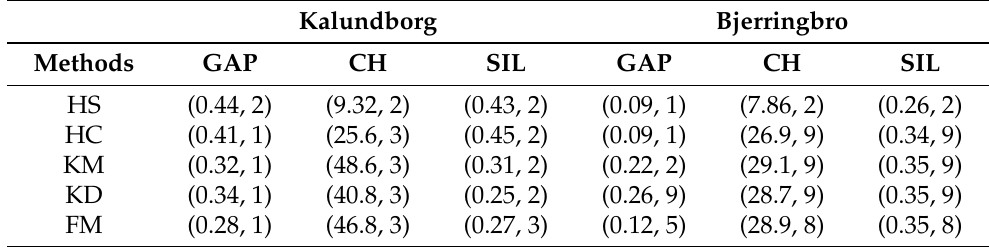
Table 5. Optimal partition for both regions according to the different stopping criteria (statistic, number of clusters), for the Gap (GAP), Calinski–Harabasz (CH), and Silhouette (SIL)